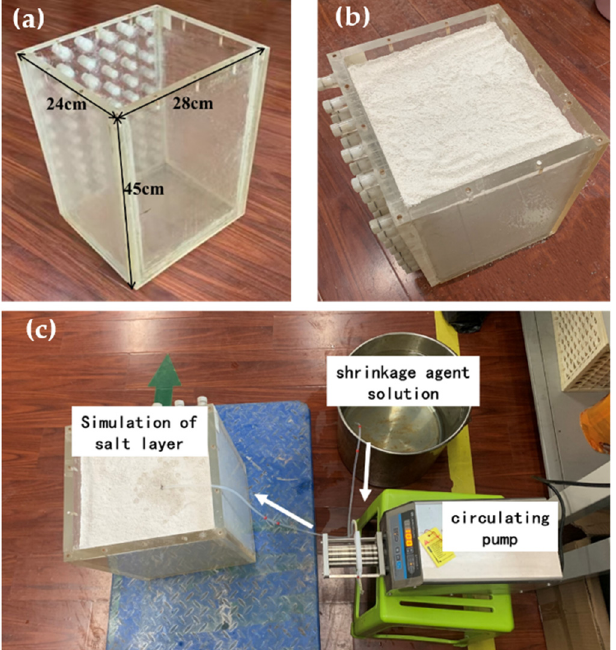
Figure 2. Large-scale dynamic salt solution simulation device. ( a ) A container of insoluble sedi- ments, ( b ) a container filled with insoluble sediments, and ( c ) a large-scale dynamic salt solution simulation device.